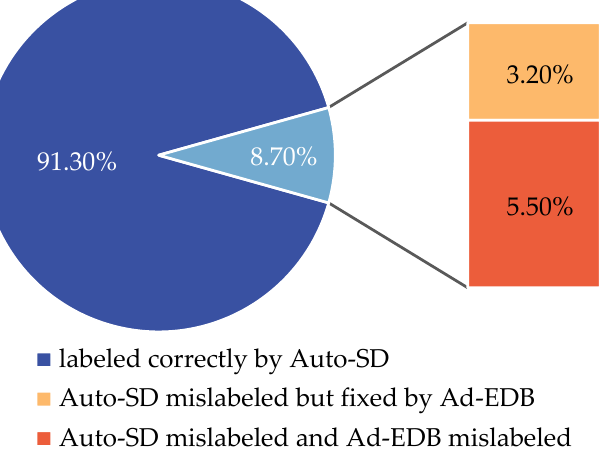
Figure 11. Specific generation occupancy and repair occupancy for a frame interval of 1. In order to ensure the matching effect of the constructed Ad-EDB in selecting the image classifier according to the noise rate of the generated labels, this paper processed the original correctly labeled data set. No more than 20% of the labels were randomly selected for image classification after alteration in the experiments, and the experimental results were averaged and analyzed. The correlation between the generated label noise rate and the accuracy of each image classification algorithm was observed experimentally, and the experimental results are shown in Figure